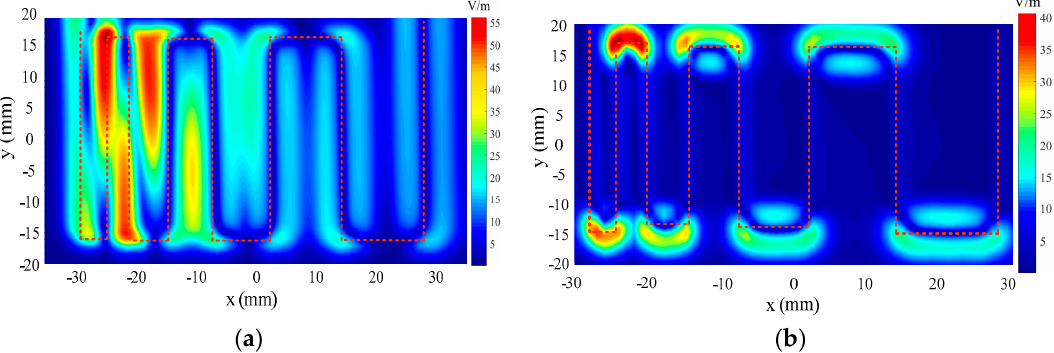
Figure 26 . Mappings of the electric-field distribution of the meander line for ( a ) Ex and ( b ) Ey.